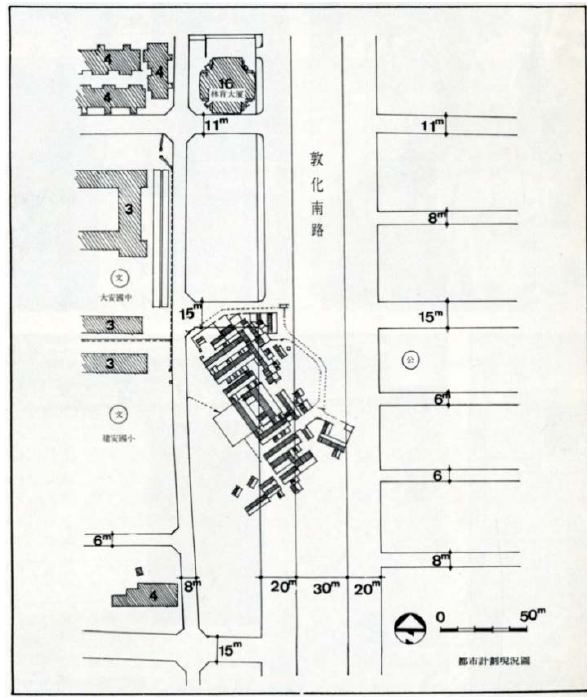
Figure 3: Taipei city government planned to extend the Dunhua South Road southwards and elected to demolish the old house （ Gan-Lang Li, 1977 ）